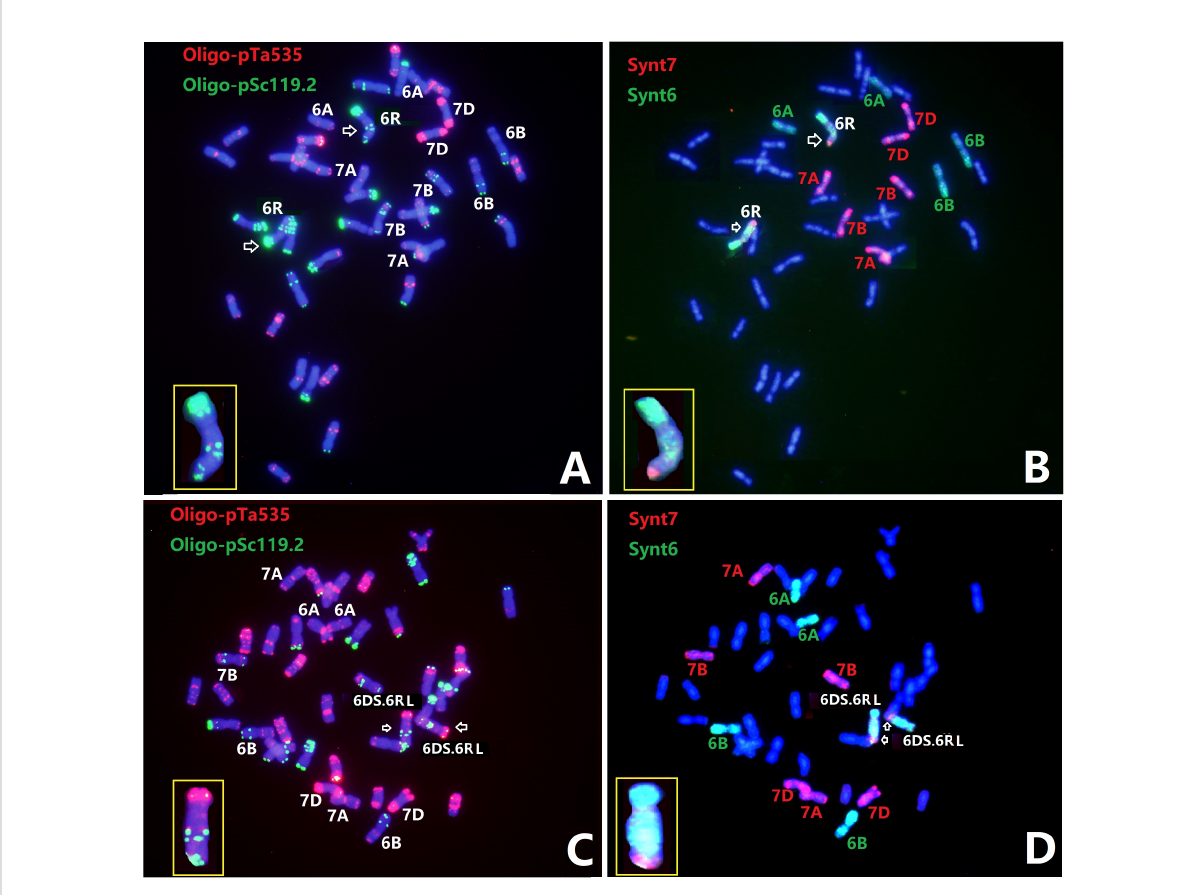
FIGURE 5 ND-FISH and Oligo-FISH painting of lines Sub6R(6D) (A, B) and R23 (C, D) . Probes Oligo-pSc119.2 + Oligo-pTa535 (A, C) and Synt6 + Synt7 (B, D) were used. The Synt7 hybridization sites corresponded to the distal two Oligo-pSc119.2 sites in